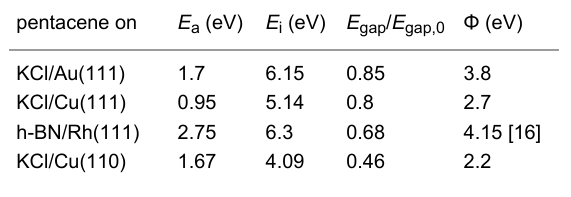
Table 1: Experimental values for E a , E i , E gap / E gap,0 for pentacene as well as the values for Φ . Φ has been determined experimentally for the KCl layers on the different substrates by I ( z ) measurements per- formed within the Ph.D. Thesis of A. Kabakchiev [20]. For h-BN, a liter- ature value is